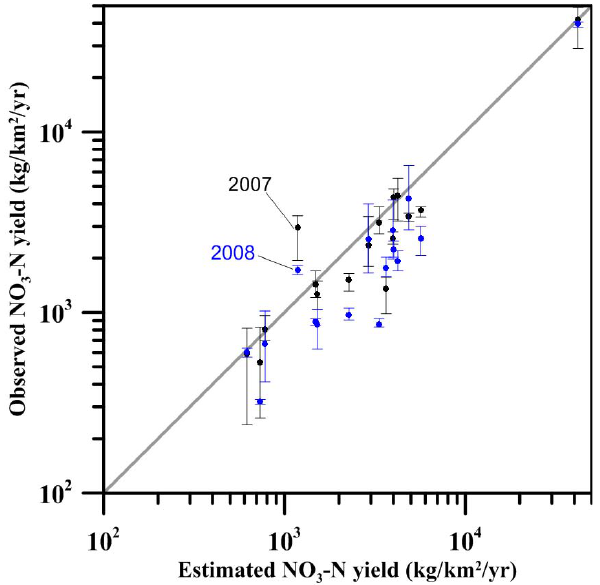
Fig. 7. The estimated (x-axis) and observed NO 3 -N yield (y-axis) for the 16 sites. The black and blue circles represent the results of 2007 and 2008, respectively. The error bars represent the ranges of four-method-derived yields for the observed yields. The diagonal line indicates the 1:1